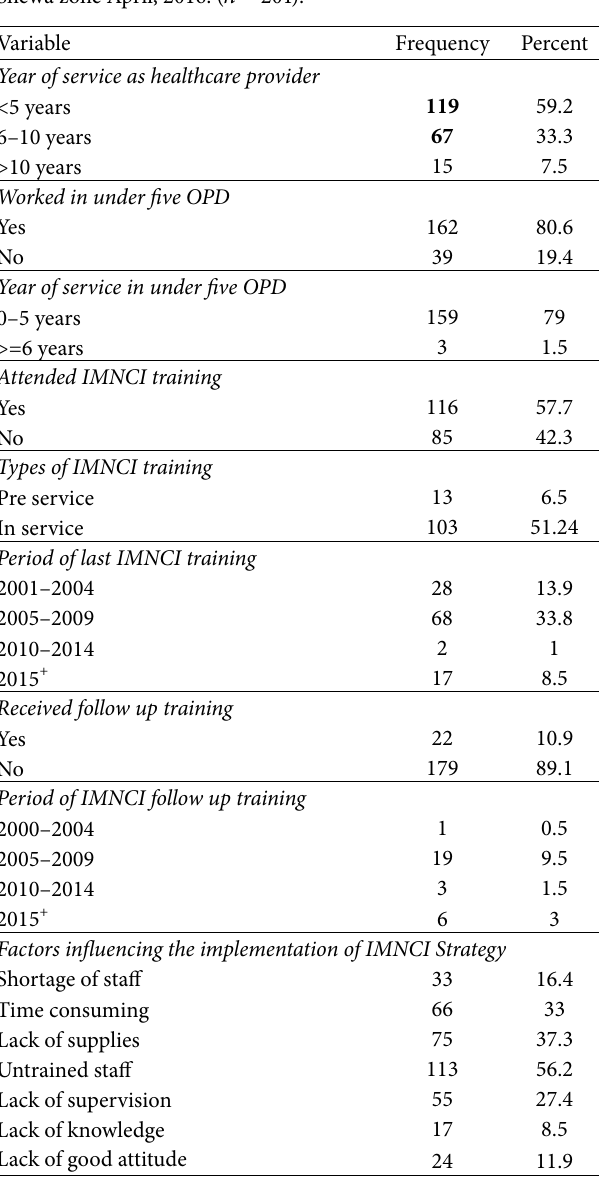
Table 1: Socio-demographic characteristics of respondents among health care professionals in Public health institution of Yifat, North Shewa zone April, 2018 ( 𝑛 = 201 ).